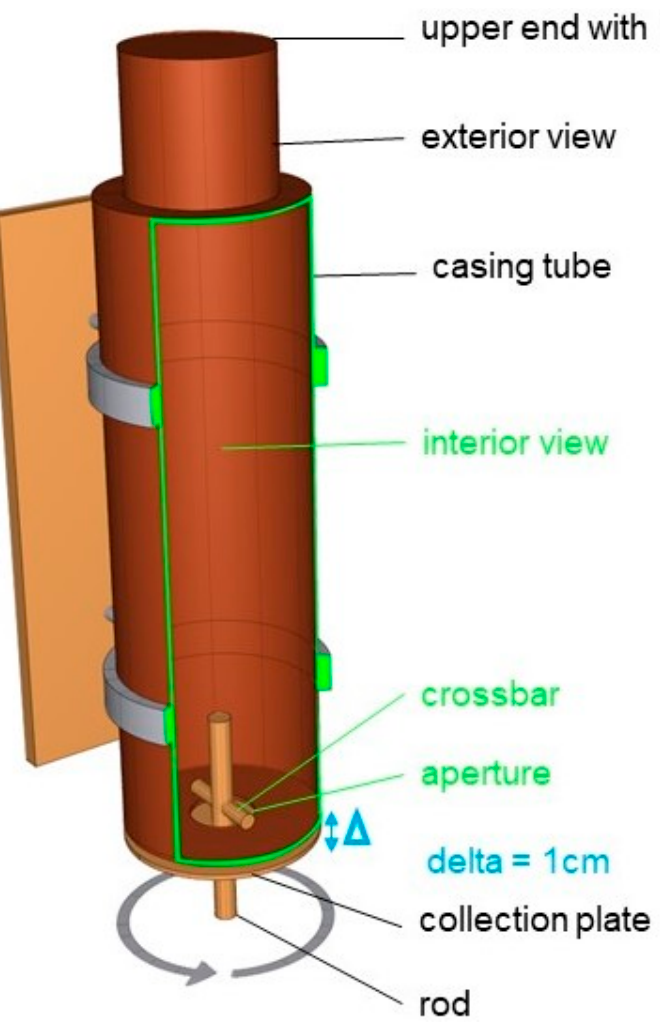
Figure 2. Operation mode of the feeder. When the animals turn the rod, feed falls through the aperture (Ø 6.5 cm) on a plate 1 cm below. Further turning of the rod and the plate makes the feed fall into the horses feeding trough. The rod can be turned to the right and left side.